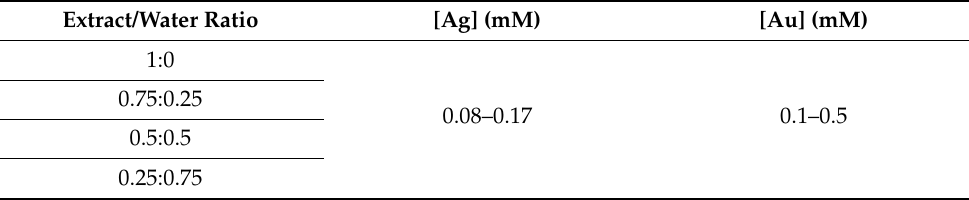
Table 3. Reaction conditions employed for the synthesis of gold and silver nanoparticles. Extract/Water